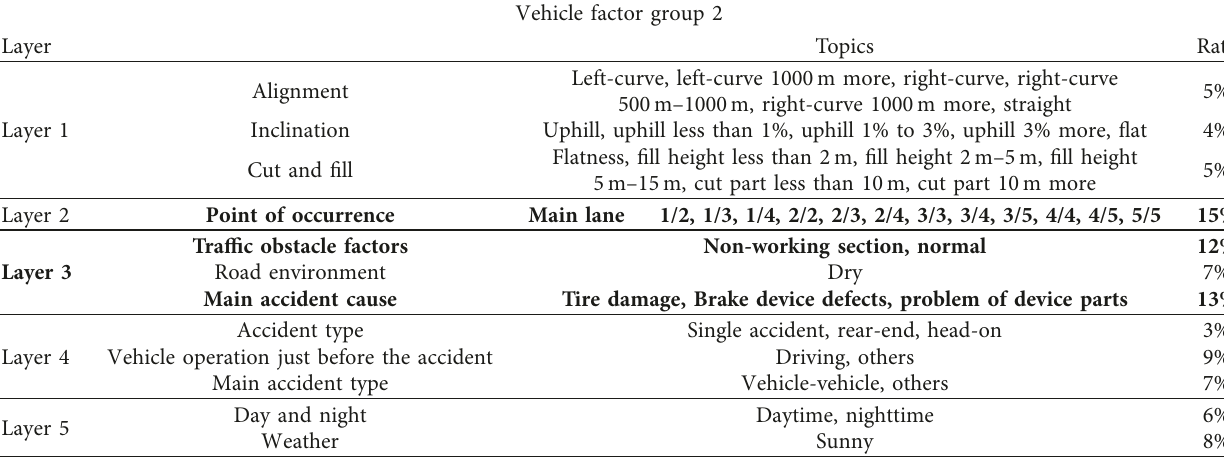
Table 6: Vehicle factor topic modeling group